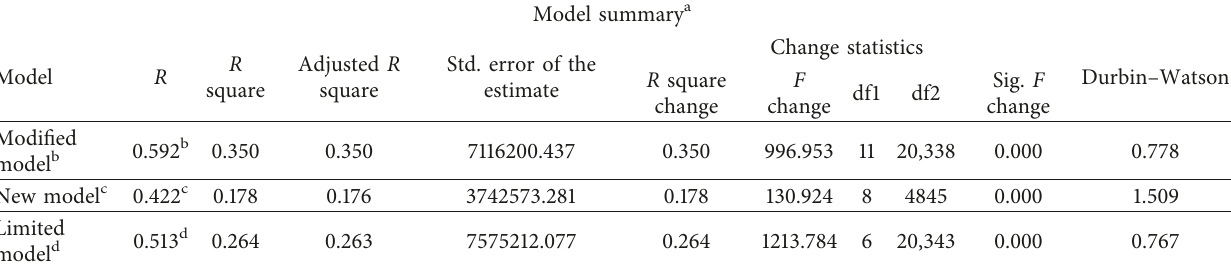
Table 6: Model summary for a DOE small office building depending on different